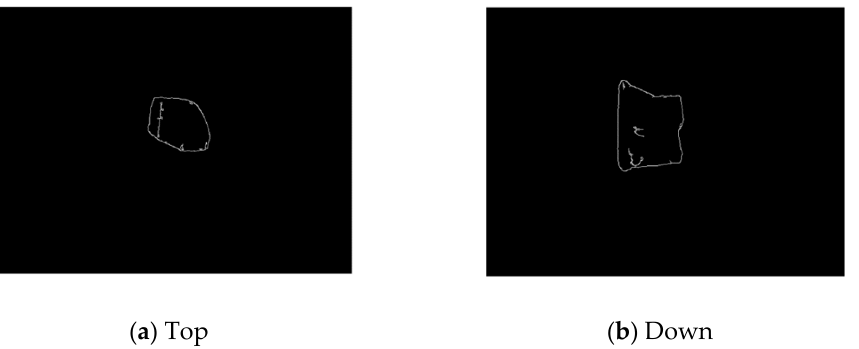
Figure 3. Binarized Canny edge detection.